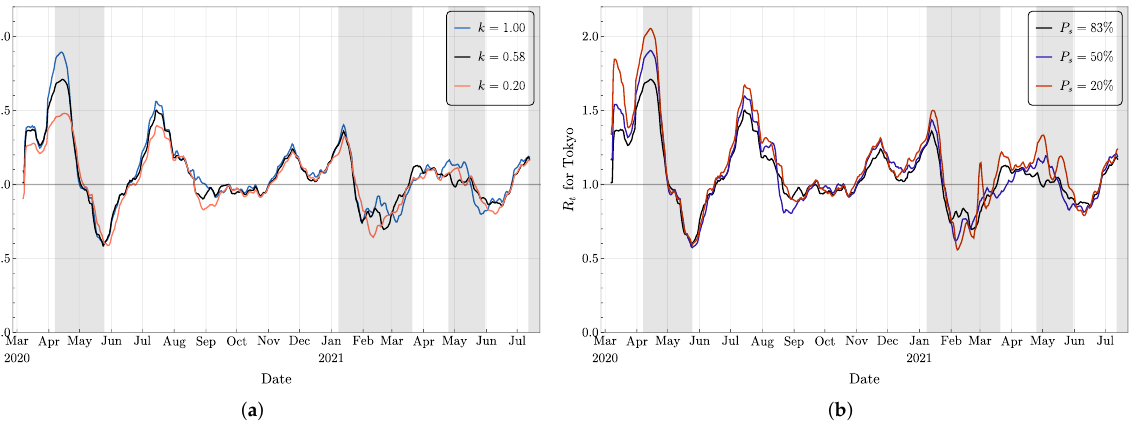
Figure 10. Mean values of R t for: ( a ) different values of the relative infectivity k and ( b ) different probability P s of developing